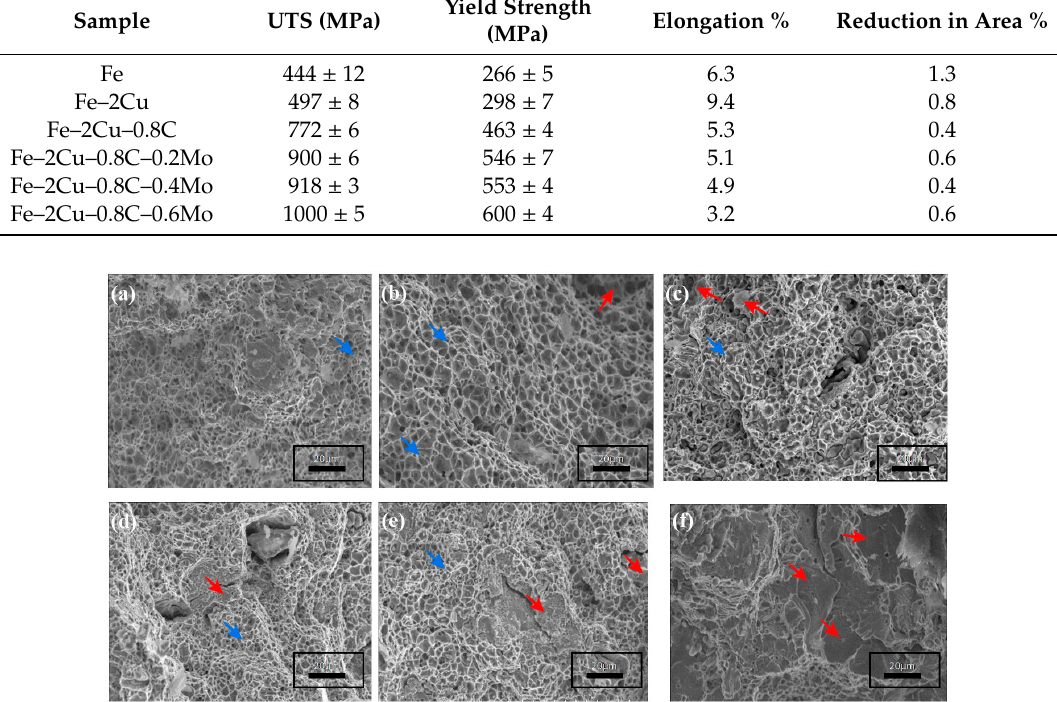
Table 5. E ff ect of alloying addition on the tensile properties of carbonyl iron compacts [21]. Table 5. Effect of alloying addition on the tensile properties of carbonyl iron compacts